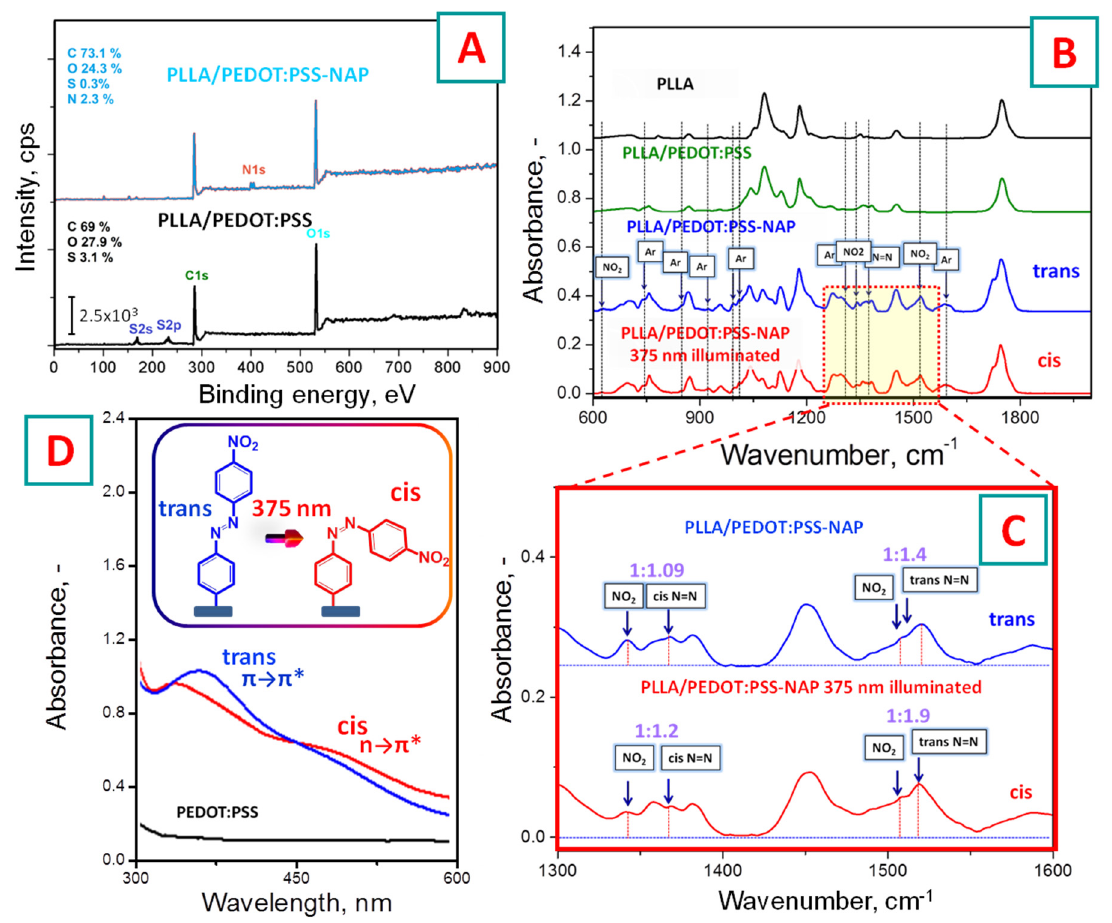
Figure 2. (A ) XPS spectra of pristine PEDOT:PSS and PEDOT:PSS-NAP films deposited on PLLA substrate; ( B ) FTIR spectra measured on pristine PLLA substrate, PLLA substrate with PEDOT:PSS, and PEDOT:PSS-NAP films before and after illumination with 375 nm LED wavelength; ( C ) details of the IR spectrums of PEDOT:PSS-NAP film before and after light triggering; ( D ) illumination-induced changes in UV-Vis absorption spectra of PEDOT:PSS-NAP.